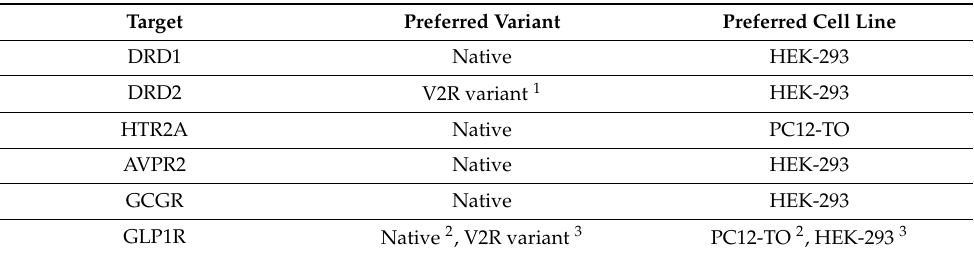
Table 2. Preferred GPCR variant and cell line for split TEV assays: effects of signal peptide (SP), V2R tail, and cell line on assay performance. The best variant was identified by the highest fold change and a paralleled Z (cid:48) -factor ≥ 0.5 across the cell lines tested.